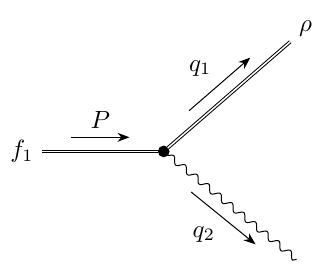
Figure 5 . Feynman diagram for f 1 → ργ consistent with M ( f 1 → γ ∗ γ ∗ )